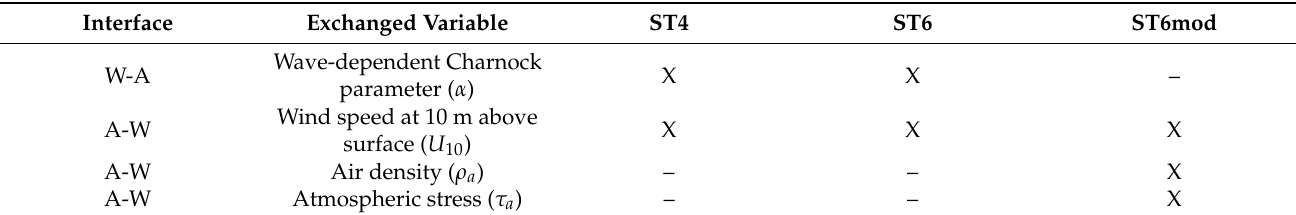
Table 1. Coupling exchanges between the atmosphere (A) and wave (W) components relevant to wave field modelling implemented in the UK Regional Coupled Atmosphere-Ocean-Wave (UKC4)